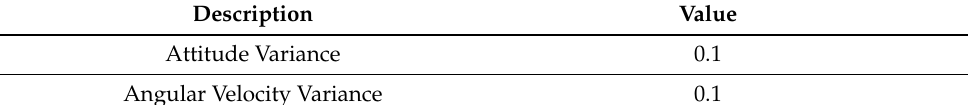
) and Initial Angular Velocity ( ω B / N 0